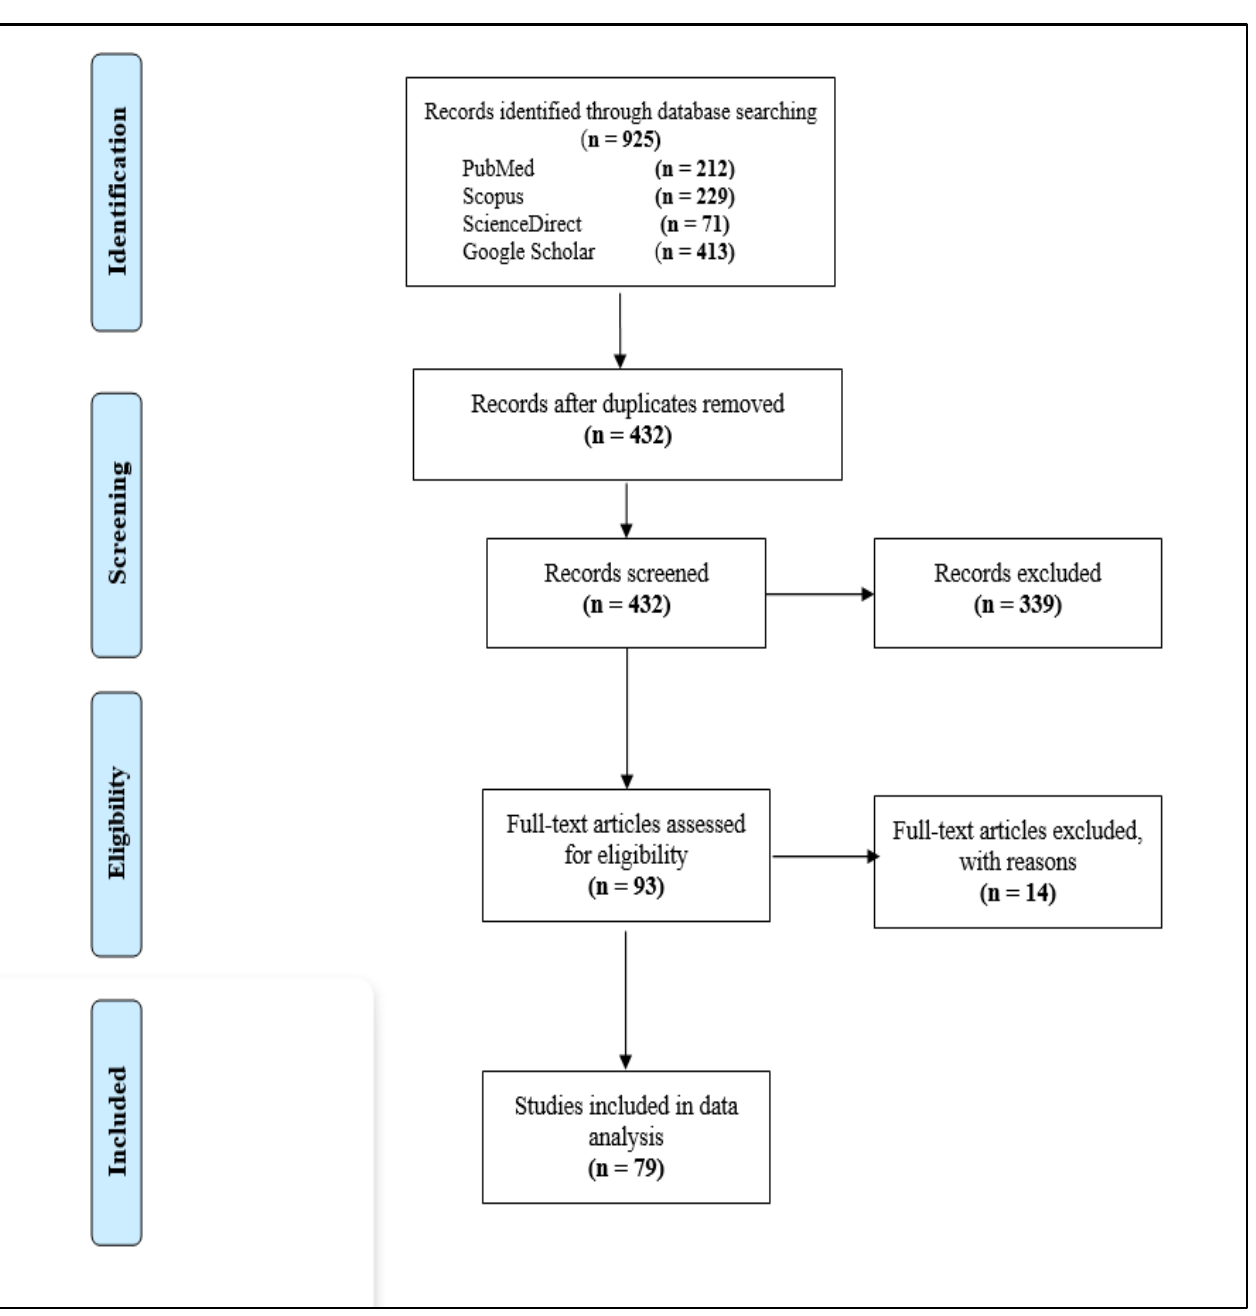
Figure 1. The PRISMA diagram showing the study selection process.